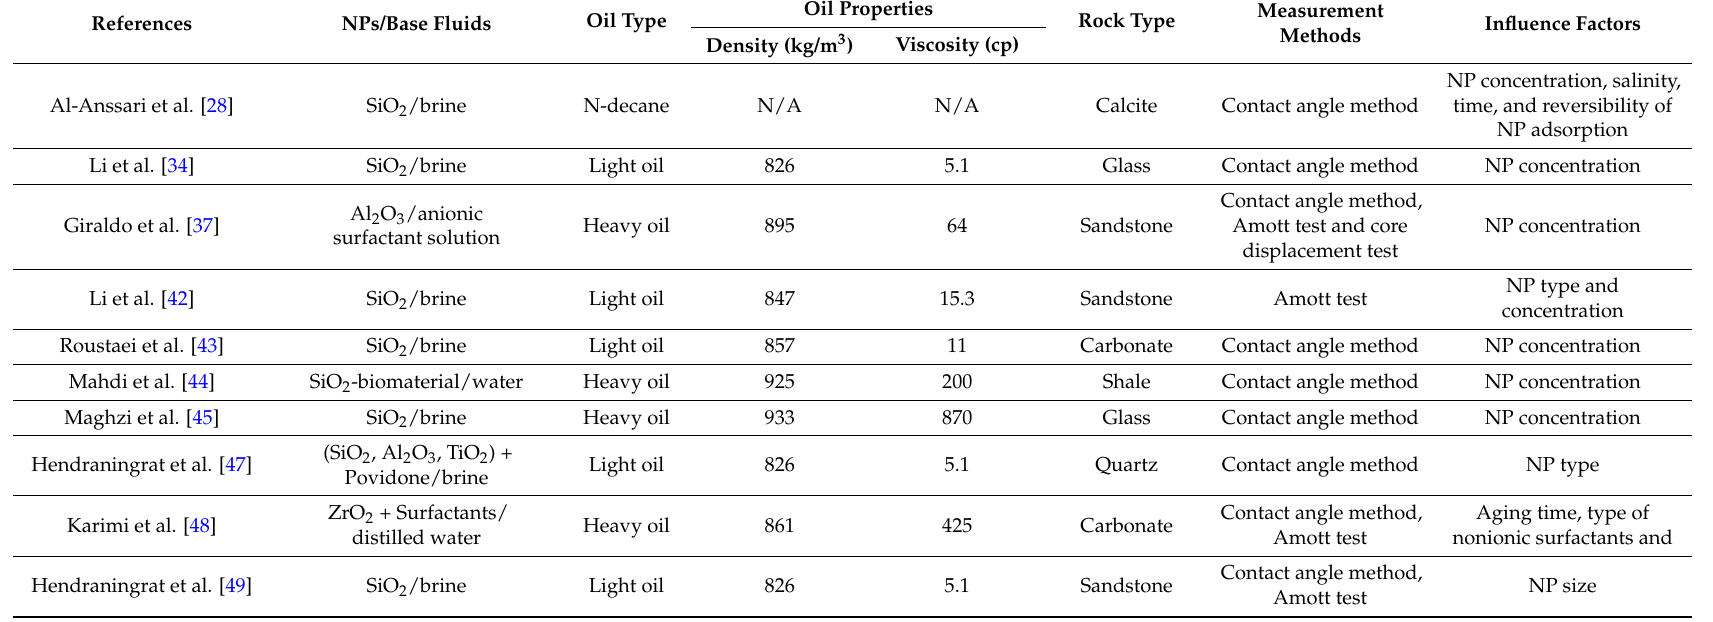
Table 1. Summary on experimental studies about wettability alteration by